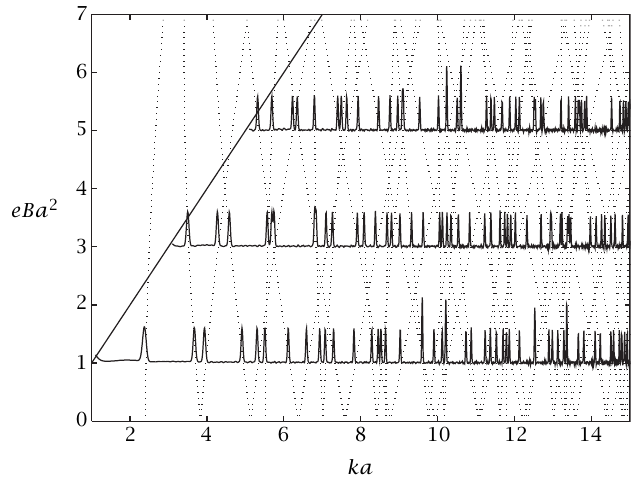
Figure 4.1 . The semiclassical level density and the quantum mechanical eigenstates in the R c > a